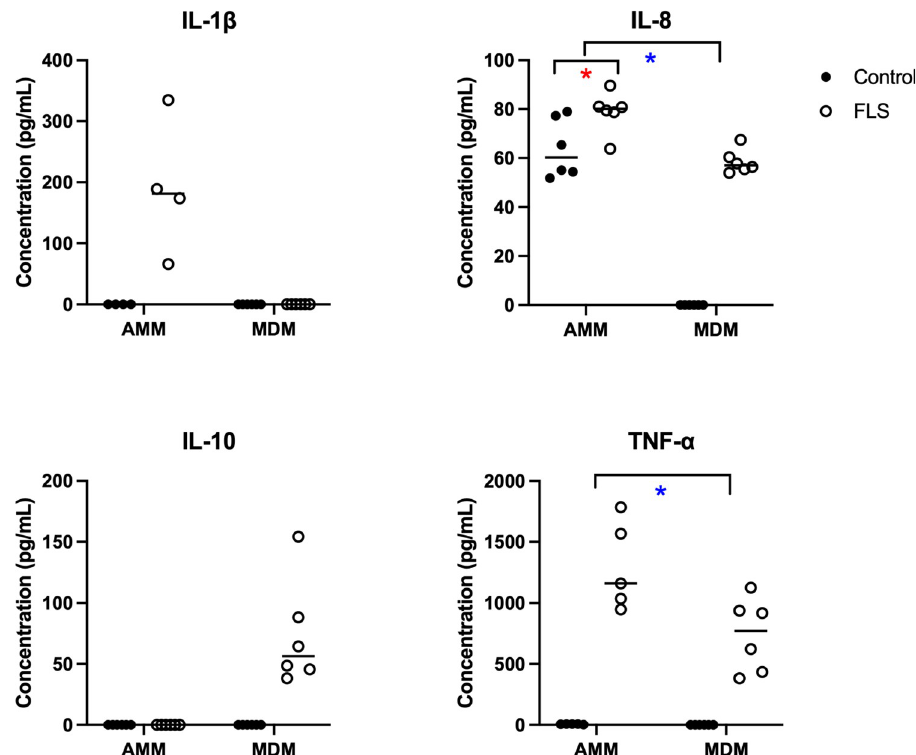
Fig 2. Mean or median cytokine concentration in alveolar macrophage/monocyte and monocyte-derived macrophage supernatant. Cells were incubated for 6 hours with serum-free RPMI (control) or FLS. Red asterisks indicate significant treatment effects of FLS incubation compared to control in each cell type. Blue asterisks indicate significant treatment effects of FLS between cell types. ND indicates non-detectable cytokine concentration.